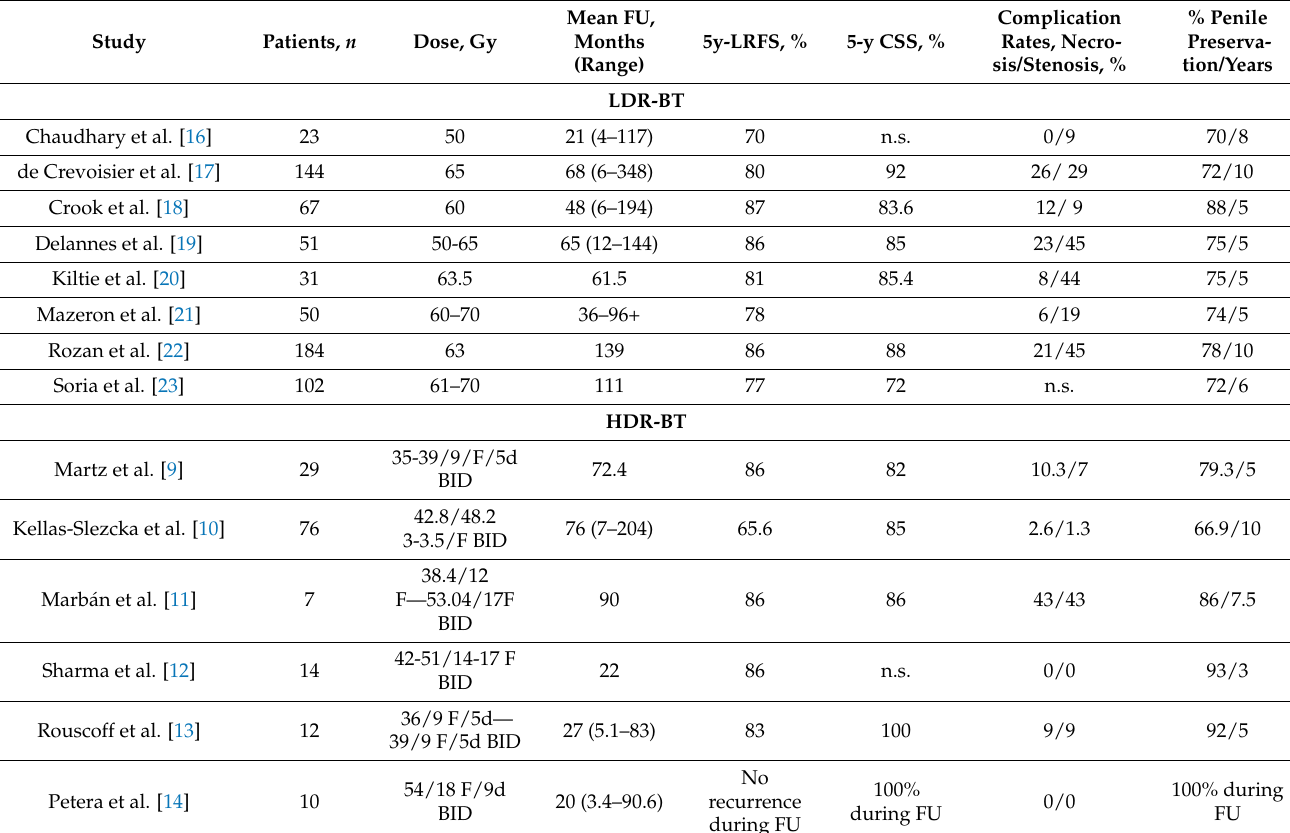
Table 3. Clinical results of main studies evaluating LDR-BT and HDR-BT for penile